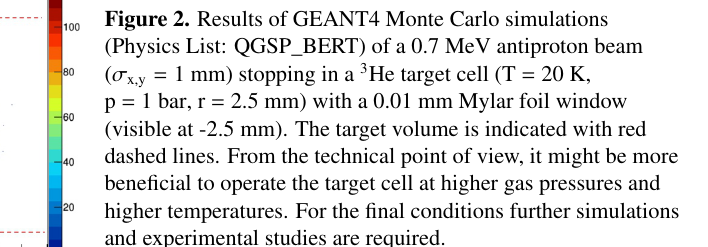
Figure 2. Results of GEANT4 Monte Carlo